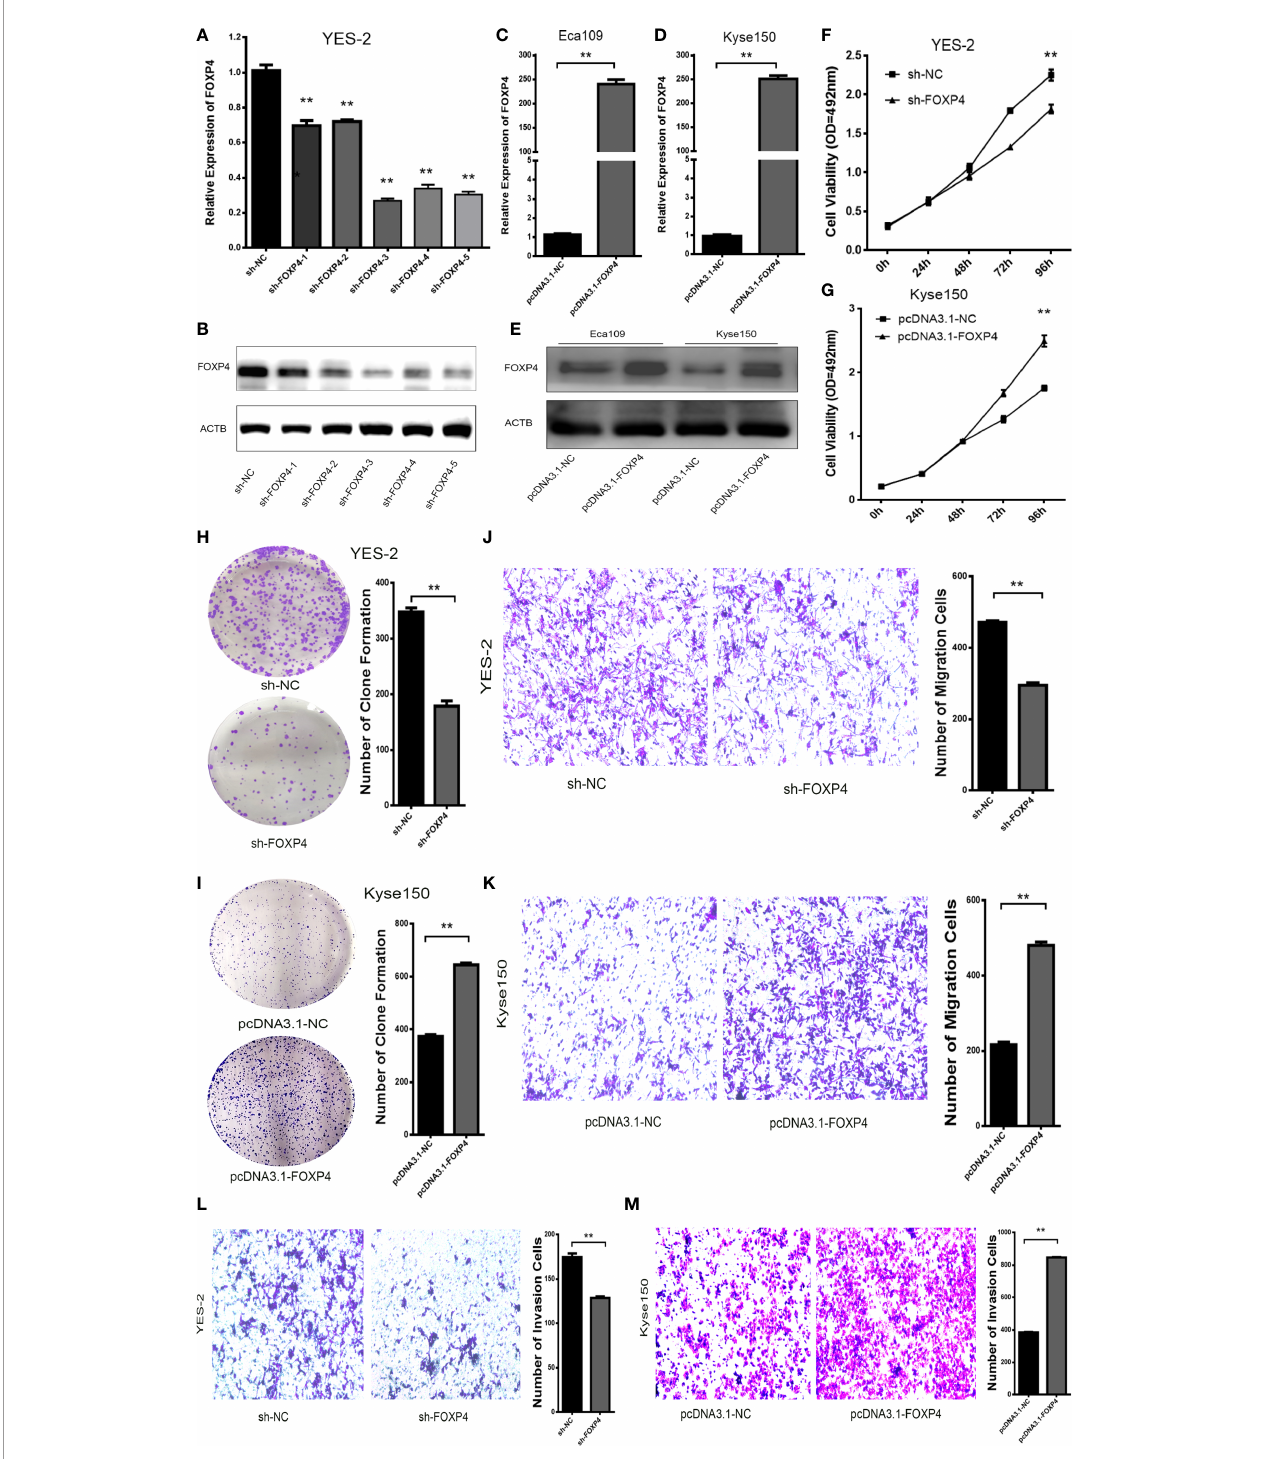
FIGURE 5 | FOXP4 promotes the malignant progression of ESCC. The expression of FOXP4 mRNA (A, C, D) and protein (B, E) in transfected sh-FOXP4 or pcDNA3.1-FOXP4 by qRT – PCR or WB. (F) MTS assay showing the inhibition of YES-2 proliferation ability with sh-FOXP4. (G) Increased proliferative capacity of Kyse150 with pcDNA3.1-FOXP4 by MTS assay. (H) Colony formation assay indicated that deregulated FOXP4 follows the lower colony formation in YES-2 cells. (I) Enhanced colony formation in Kyse150 cells with pcDNA3.1-FOXP4. Transwell migration (J) and invasion assays (K) show the decreased trans-cells of YES-2 with sh-FOXP4. Transwell migration (L) and invasion assay (M) demonstrated more Kyse150 trans-cells with pcDNA3.1-FOXP4. ** p <